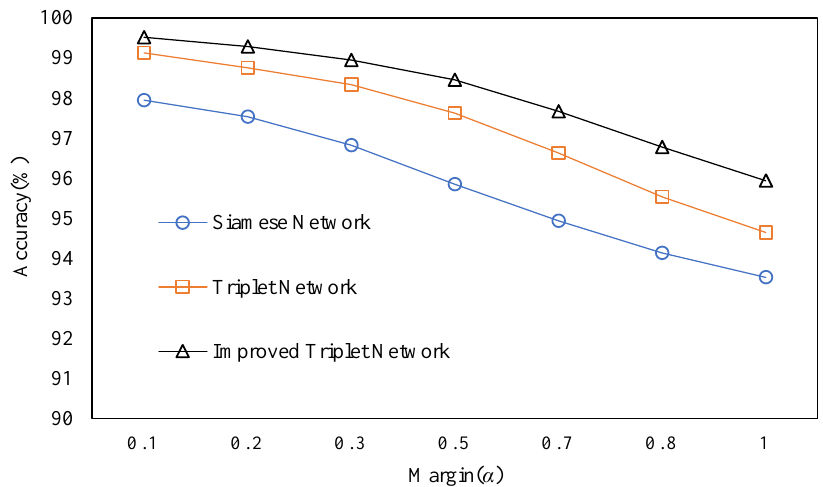
Figure 7. The classification accuracy of the three networks varies with a series of margin values.